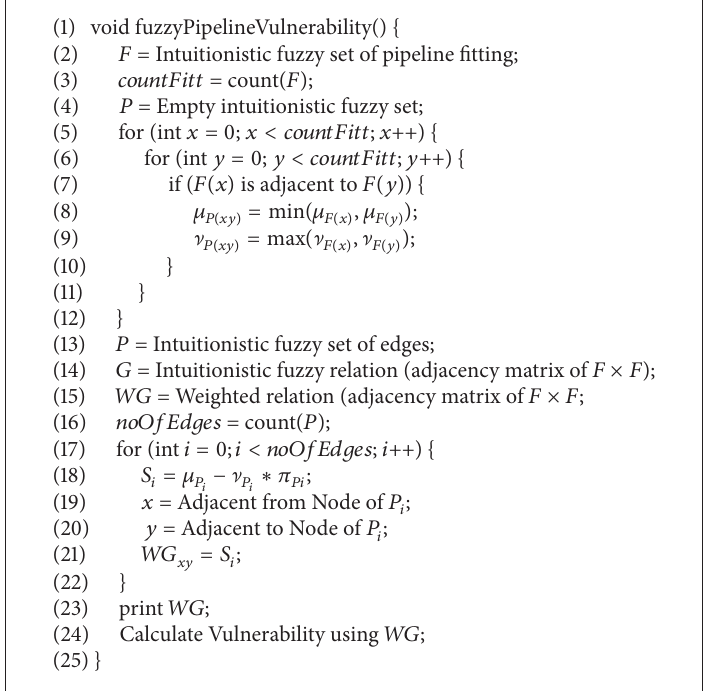
Algorithm 3: IF in vulnerability assessment of gas pipeline